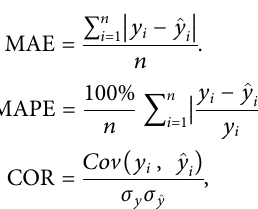
set. The optimization training data set contains the fi rst 121 data